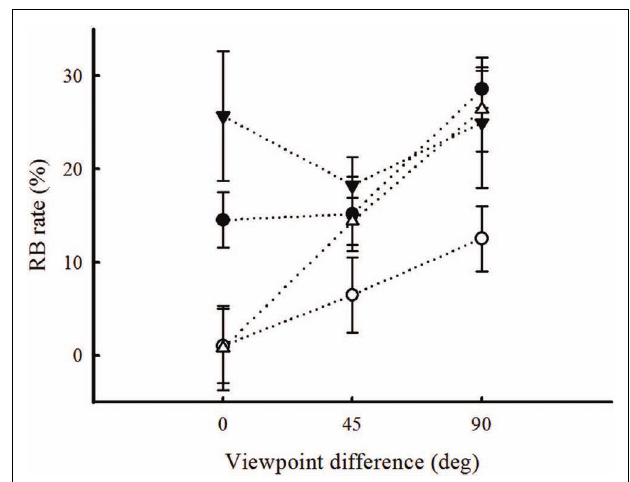
FIGURE 5 | Repetition blindness rates are plotted as a function of viewpoint for each spatial frequency condition. RB is the difference between the mean correct-response rate in the non-repeated condition and the mean correct-response rate in the repeated condition. Error bars show ±